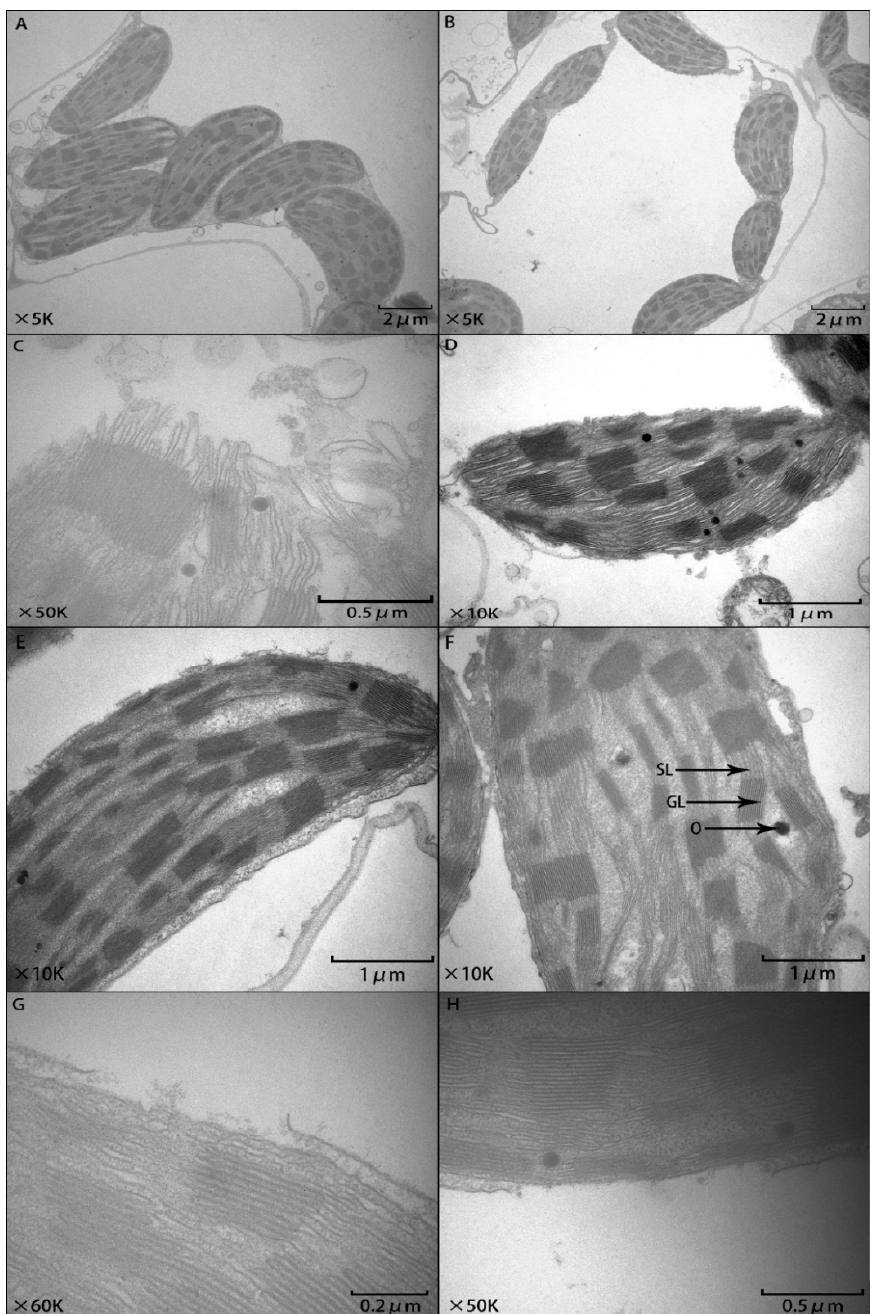
Figure 5. Effects of different concentrations of BL on chloroplast ultrastructures of maize seedlings under chilling stress. ( A , B ): CK; ( C , D ): Chilling stress T0 treatment; ( E , F ): Chilling stress T2 treatment; ( G , H ): A partial magnification of the chloroplast under T2 treatment; GL: Grana lamellae; SL: Stroma lamella; O: Osmiophilic granule.